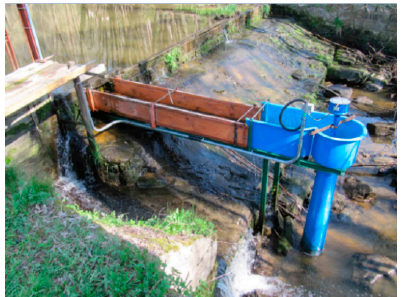
Figure 3. The small hydropower plant with a maximum power of 500 W.